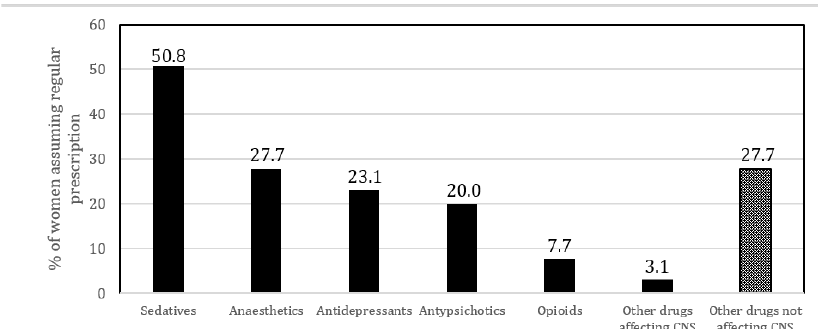
Figure 2. Usual prescriptions reported by 65 patients.